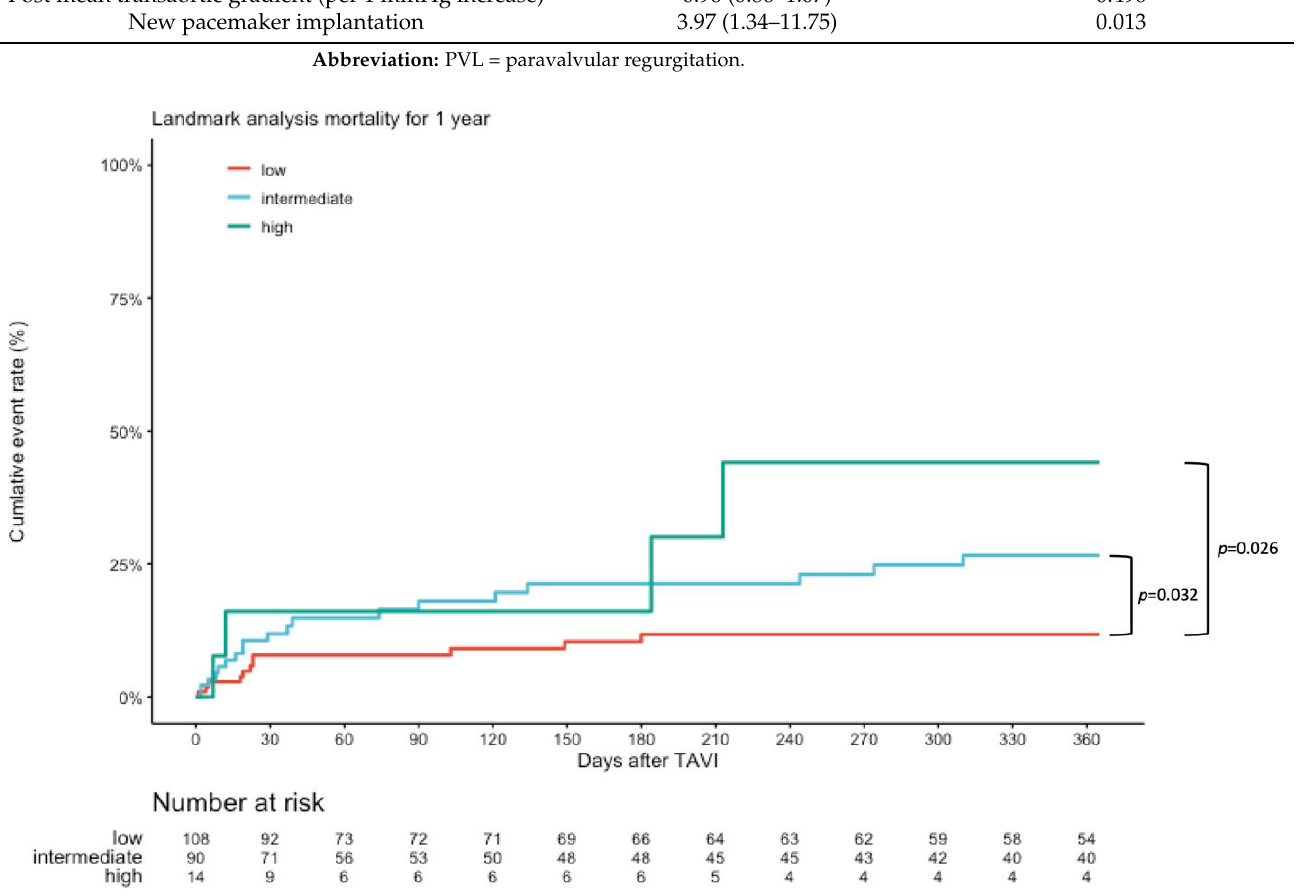
Figure 3. Kaplan–Meier survival curves for all-cause mortality. Kaplan–Meier curves for all-cause mortality during 1-year follow-up. Values are Kaplan Estimates %. HR = Hazard Ratio. Data reported as Kaplan–Meier estimates and competitive risk estimates at the specific time point and do not equal the number of patients with events divided by the total number of patients in each treatment group. The p values for event rates were calculated using Log-Rank Test.